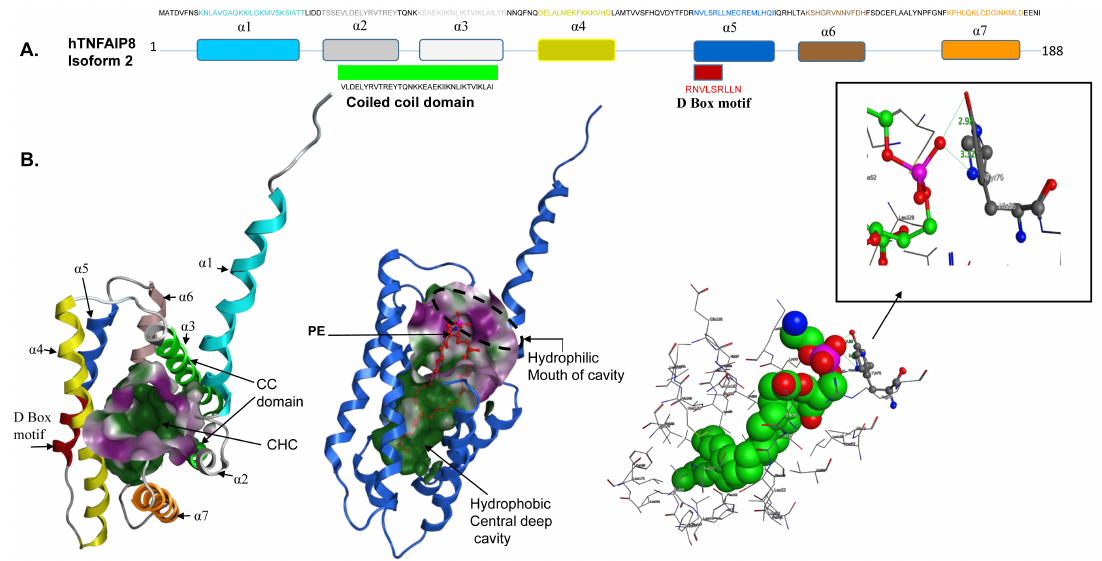
Figure 3. ( A ) The major seven α helices of human TNFAIP8 isoform 2 are presented in different colors and location of the coiled-coil domain and D-Box motif in helices are shown. ( B ) Rendering of the homology model of hTNFAIP8 isoform 2. Left panel: Colored ribbon diagram and molecular surface of the binding pocket, with pink representing the hydrophilic region and green the hydrophobic region. Middle Panel: Ribbon diagram with molecular surface of the binding pocket and the bound ligand (PE). Right Panel: Conserved pocket residues interacting with the ligand (PE). Human TNFAIP8-Tyr-76 and mouse TNFAIP8-His-86 form hydrogen bonds with the PE phosphate group, respectively. The molecular modeling software used for the graphic visualization was the Molecular Operating Environment (MOE 2016, Chemical Computing Group, Toronto, ON, Canada). The binding site surface was generated as molecular surface based on the alpha spheres generated in MOE. By MOE convention, pink color indicates hydrophilic surface region and green indicates hydrophobic